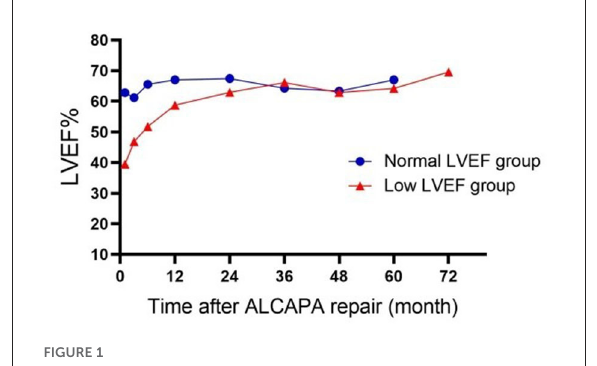
FIGURE1 Dynamic change of LVEF after ALCAPA repair. LVEF, left ventricular ejection fraction.